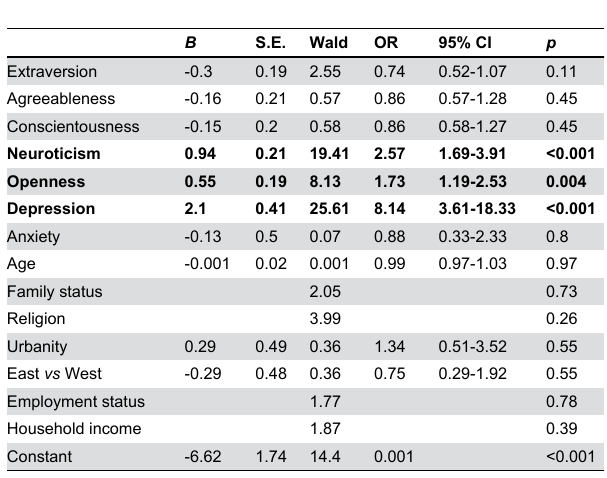
Table 6. Logistic regression analysis of suicide risk for females